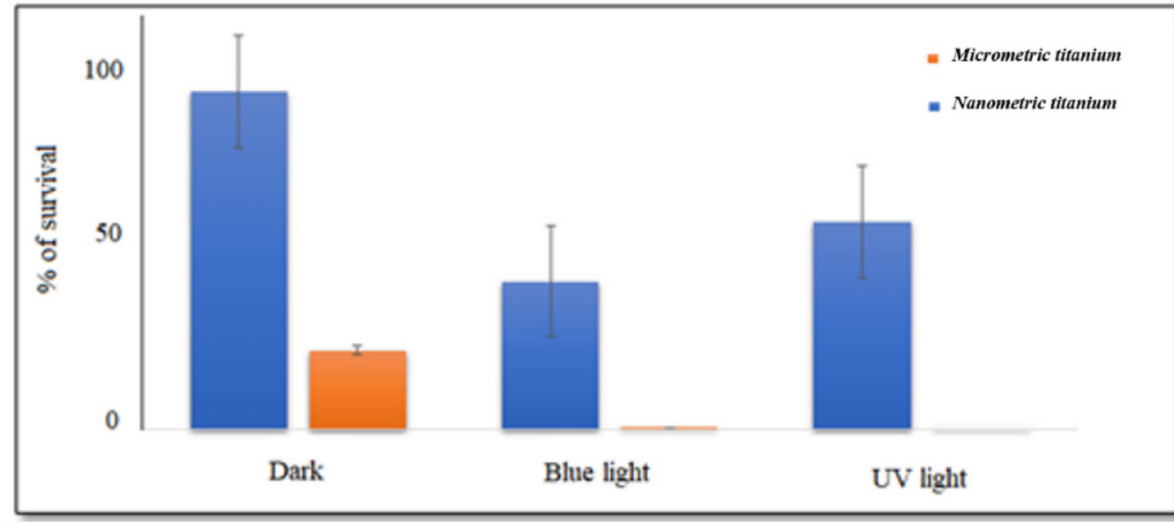
Figure 3. Antimicrobial activity of micrometric and nanometric TiO 2 in water. UV and blue light irradiation trigger the antimicrobial potential of TiO 2 microparticles, showing an even higher efficiency with respect to nanometric particles. Comparison at different wavelengths (dark, blue light at 450–455 nm and UV-light at 395–400 nm) in water using E. coli as a model after 15-min